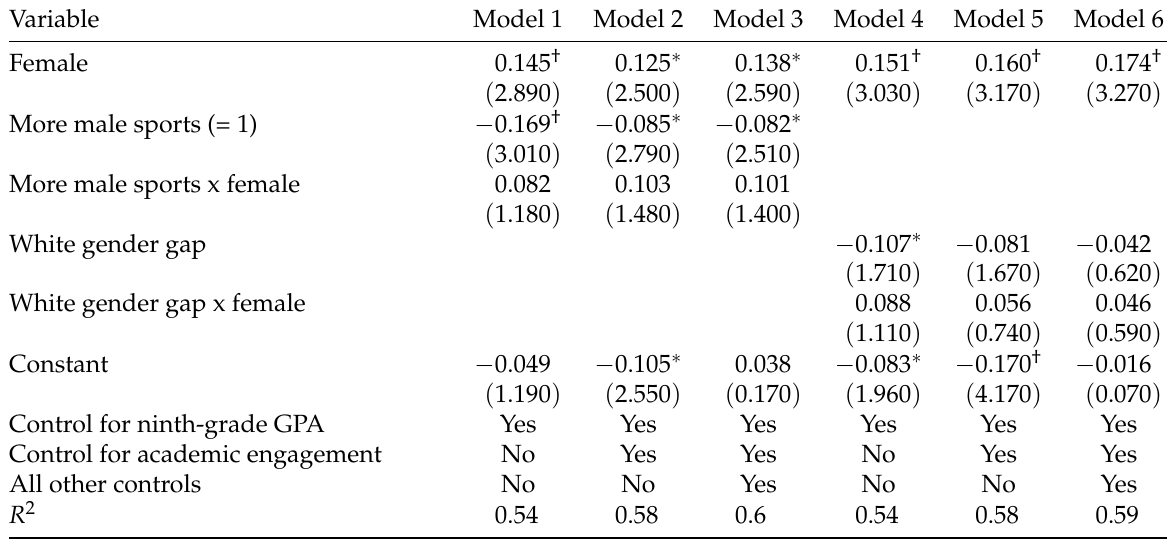
Table 5: Effects of schools on 11th-grade GPA of Asian American students,